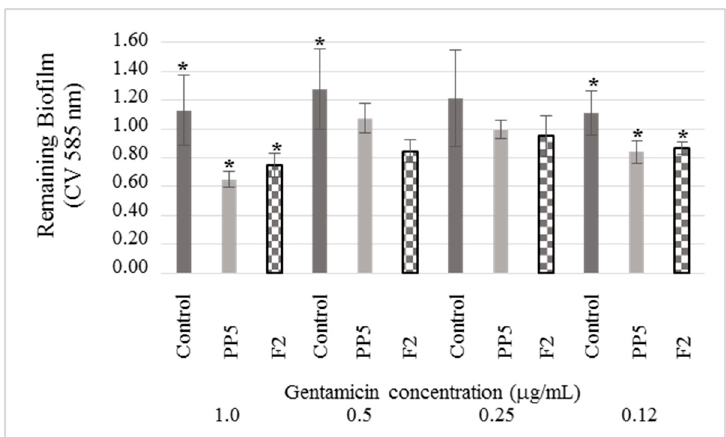
Figure 6. The effect of gentamicin on the elimination of mature biofilm formed under the effect of 2´-hydroxycinnamic acid and 3-methyl-2(5H)-furanone inhibitors (30 h incubation). These compounds increased the sensitivity of the biofilm of K. pneumoniae to gentamicin. For both substances the relative reduction of biofilm concerning the control and to each concentration of gentamicin it is appreciated. Results along with the standard deviation are presented as average values. The asterisk (*) represents values lower than the average of the control of each antibiotic concentration with statistically significant difference (* p < 0.05) (n = 5).